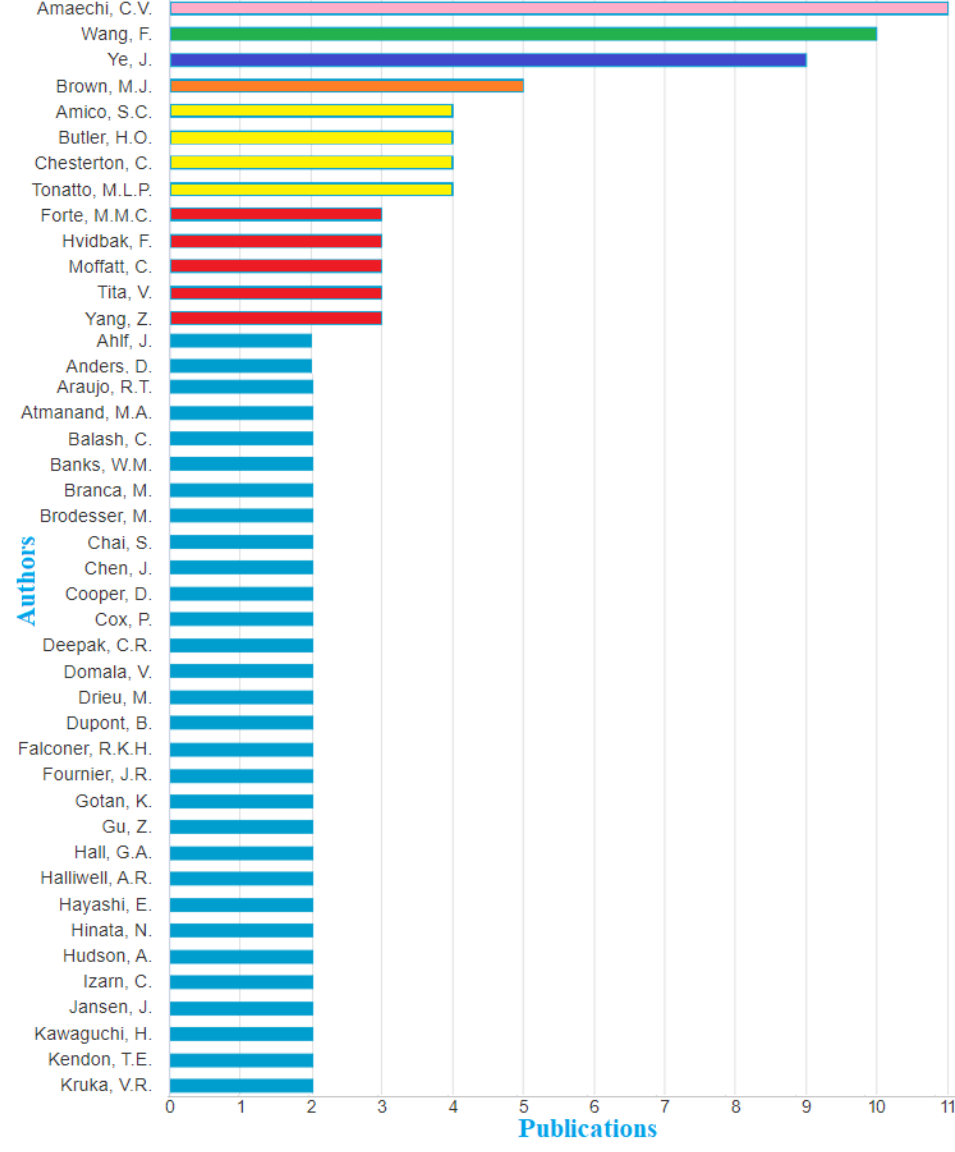
Figure 14. The authorship for the research on “marine hose” showing the top authors in chronological order (data retrieved from Scopus database, 24 July 2022).